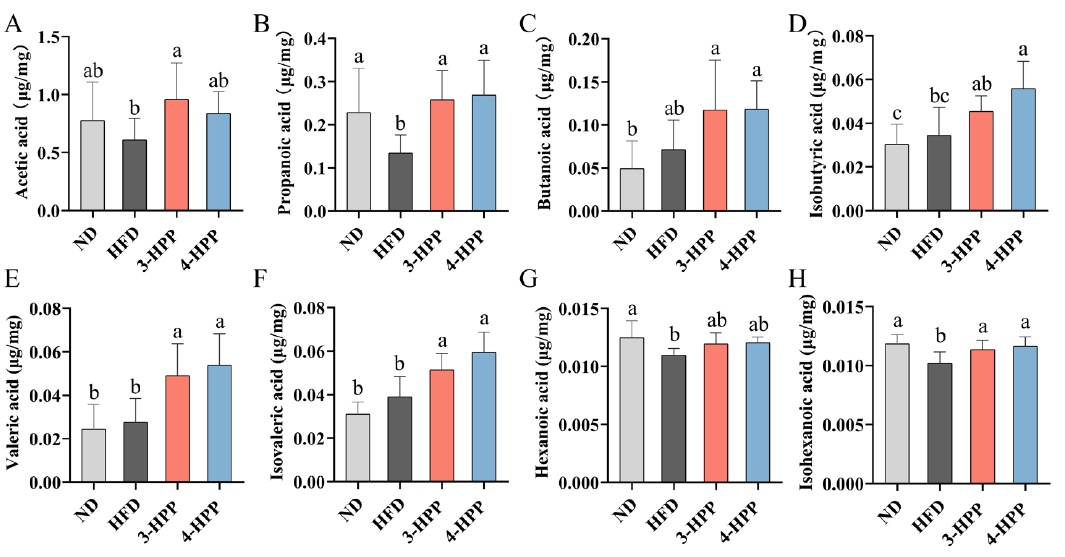
Figure 8. The effects of 3 − HPP and 4 − HPP on SCFAs content of feces. Fecal concentrations of acetic acid ( A ), propanoic acid ( B ), butanoic acid ( C ), isobutyric acid ( D ), valeric acid ( E ), isovaleric acid ( F ), hexanoic acid ( G ), and isohexanoic acid ( H ). n = 6 if not specified. According to Duncan’s test, mean values with different letters mean significant differences at p < 0.05.